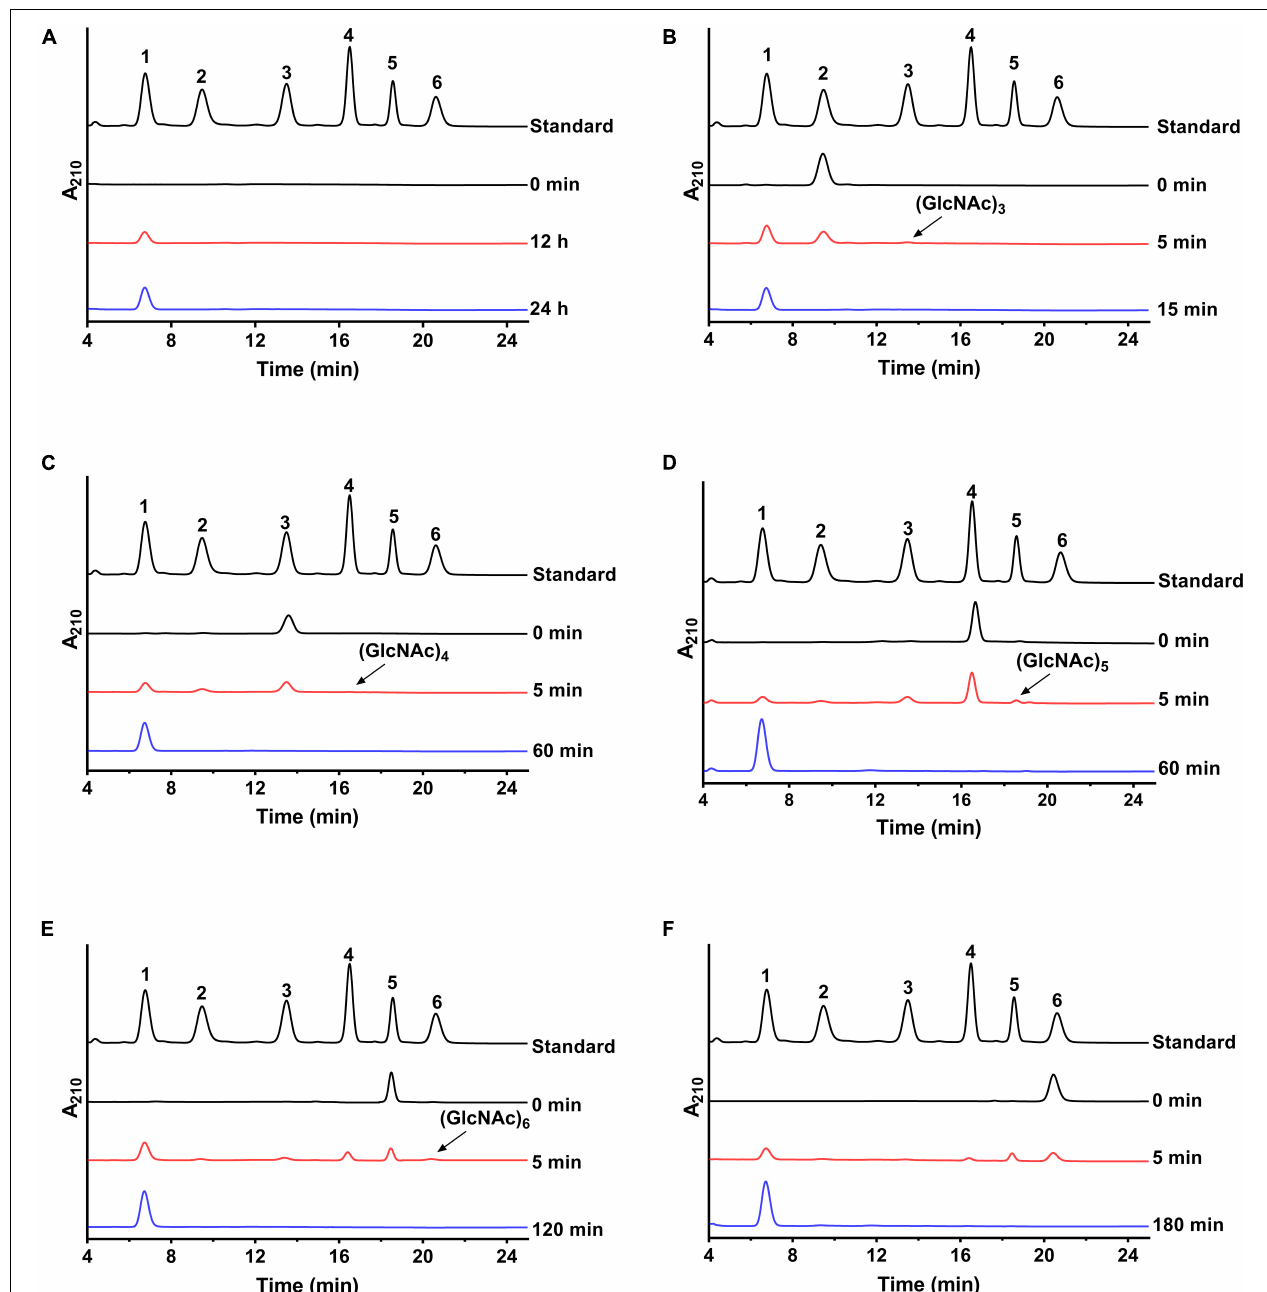
FIGURE 4 | Hydrolysis analysis of NAGaseA toward colloid chitin and N -Acetyl COSs. (A) Colloid chitin and (B–F) (GlcNAc) 2 - 6 were performed in PBS (pH 6.5) at 40 ◦ C contained 60 ng NAGaseA and 10 g/l various substrate. Numbers 1–6 represent GlcNAc to (GlcNAc) 6